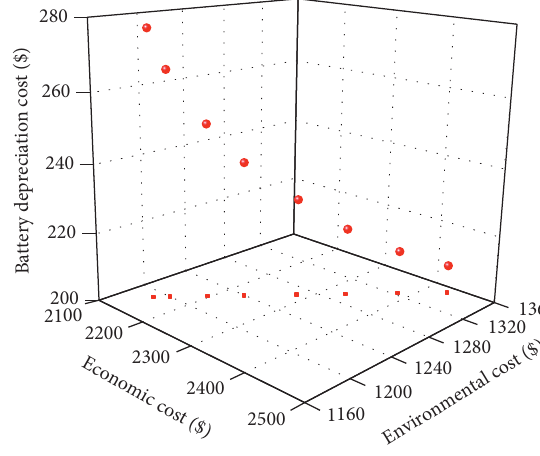
Figure 8: Pareto front solutions by the SAPSO algorithm. Table 6: Costs of different schemes.